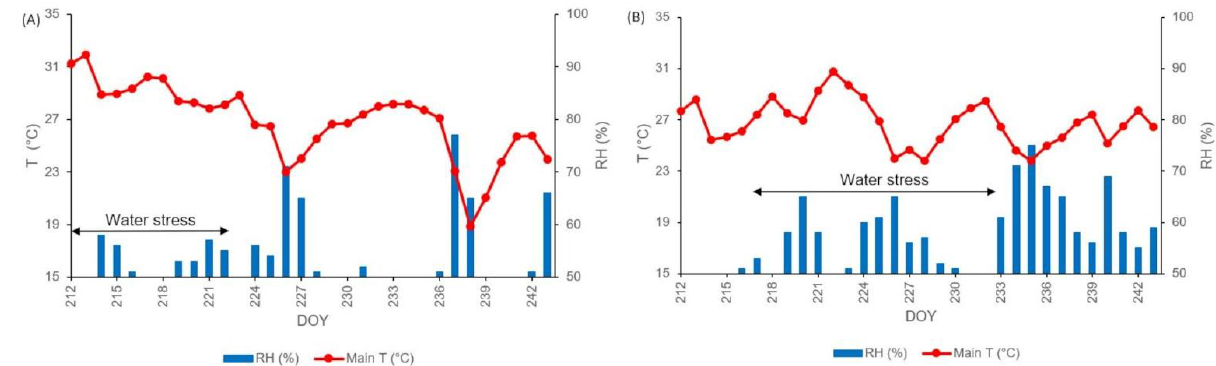
and 2019 ( B ) seasons. The duration of the water stress period is indicated by black double